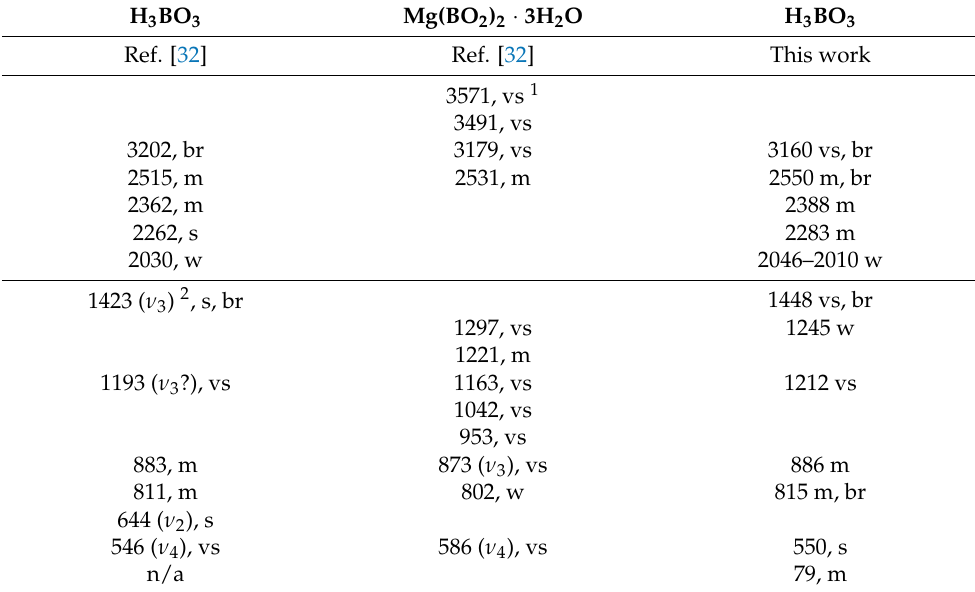
Table 2. FTIR features of H 3 BO 3 (planar B tri- O groups) and Mg(BO 2 ) 2 · 3H 2 O (tetrahedral B tetra- O groups) [32] in comparison with our data for H 3 BO 3 . All of the frequencies are in cm − 1 .